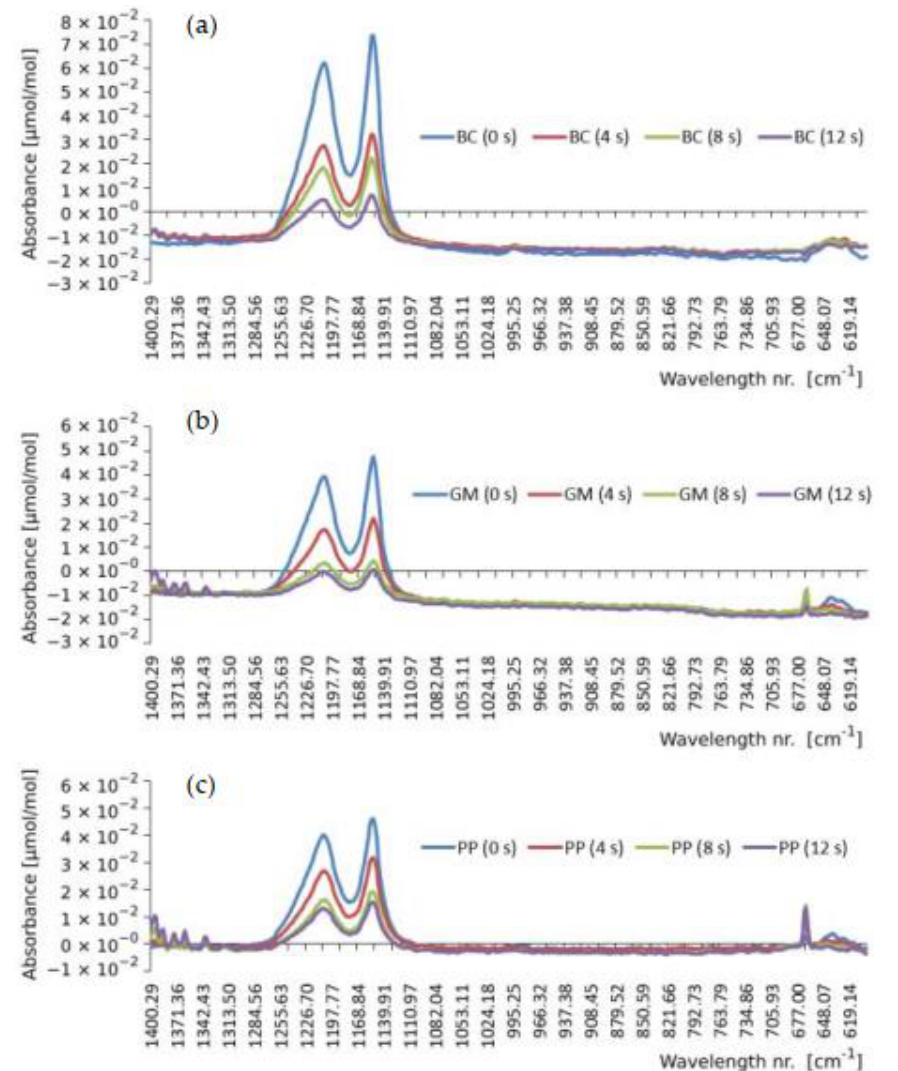
Figure 14. Evolution of the absorbance intensity of PFA coating after 0, 4, 8, and 12 s of wear via the projection of ( a ) brown corundum (BC), ( b ) glass microspheres (GM), and ( c ) plastic-polymer